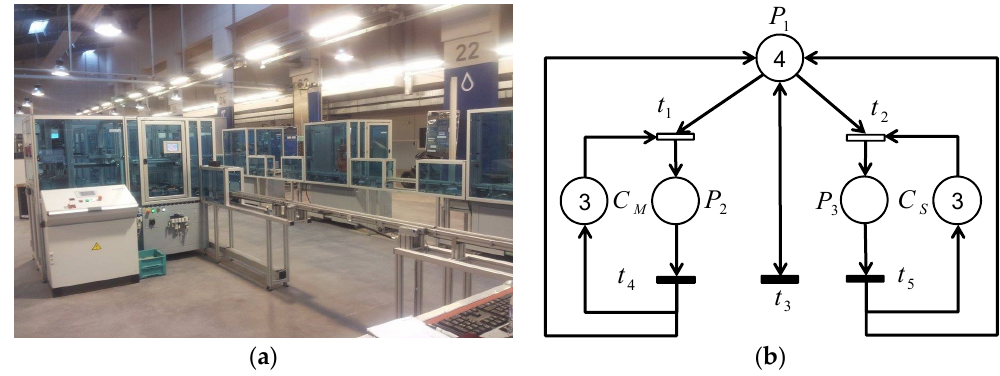
Figure 6. Flexible manufacturing system: ( a ) experimental environment; and ( b ) PN model.